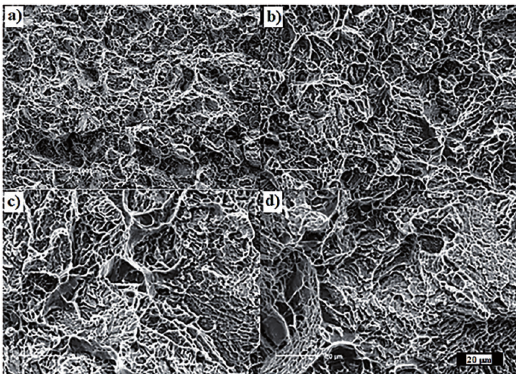
Figure 7: Cross section of test specimens after the Charpy test presenting ductile fracture for annealing and aged samples. Annealing temperature in ° C (Charpy absorbed energy in J) a) 950 °C (18,39J); b) 1000 °C (23,05J); c) 1050 °C (21,83J), d) 1100 °C (14,87J). The Charpy toughness tests were performed with subsize specimens with cross section